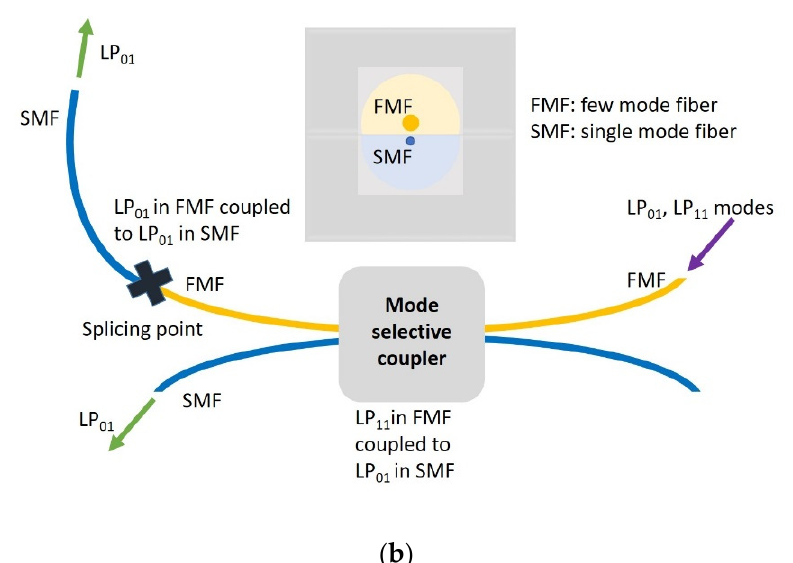
Figure 1. ( a ) Multimode OCT schematic with the FMF-based mode-selective coupler. SMF: single mode fiber; FMF: few-mode fiber; BPD: balanced photodetectors; BS: beam splitter; ( b ) Proposed FMF detection module.